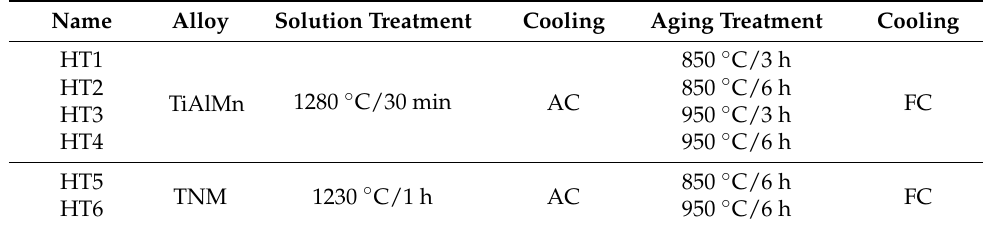
Table note, TiAlMn: Ti-42Al-5Mn alloy; TNM: Ti-43Al-4Nb-1Mo-0.5B alloy; AC: air cooling; FC: furnace